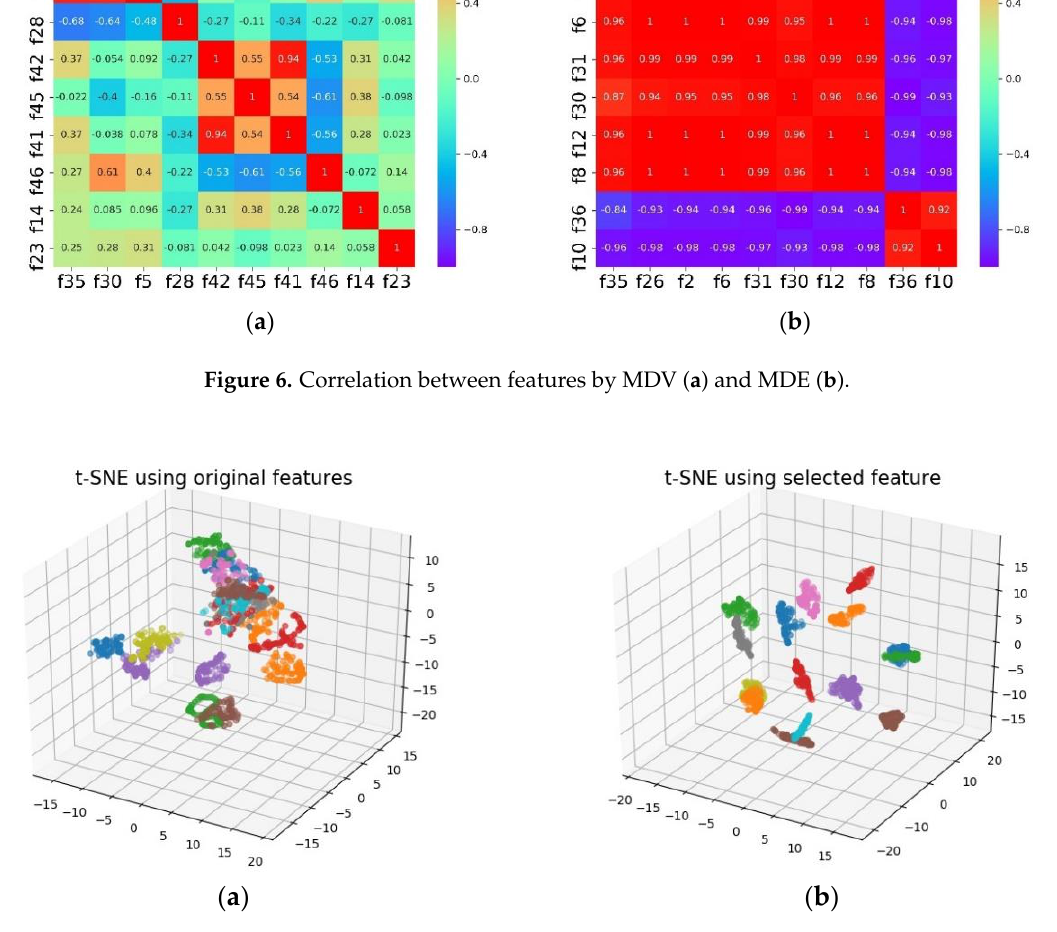
Figure 7. 3D visualization by t-SNE: ( a ) t-SNE using original features; ( b ) t-SNE using selected features.